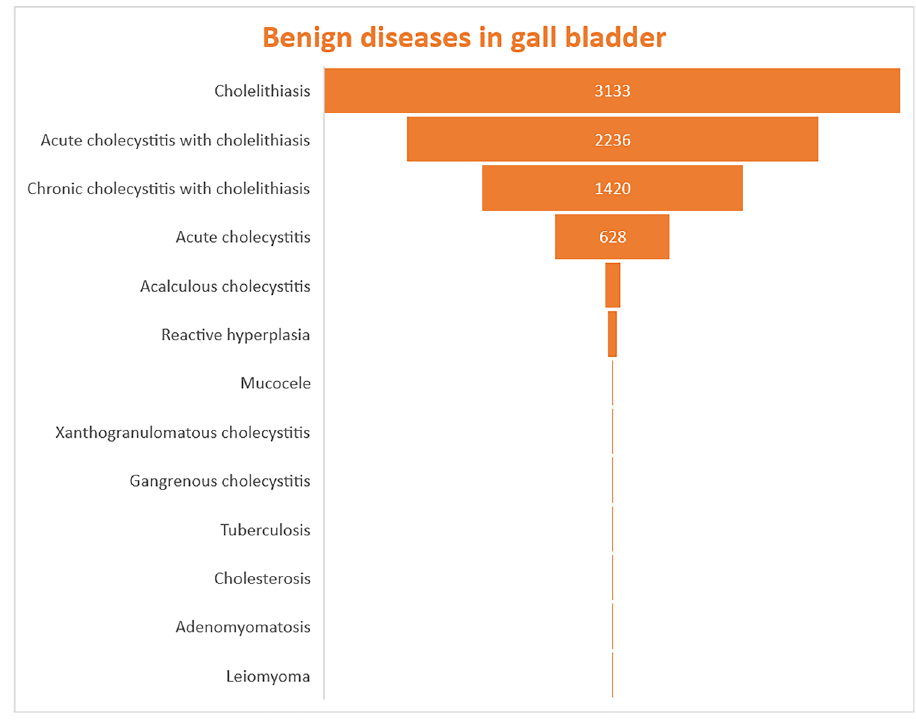
Figure 1. Chart showing the prevalence of benign gall bladder diseases in North-Western India (Numbers represent absolute